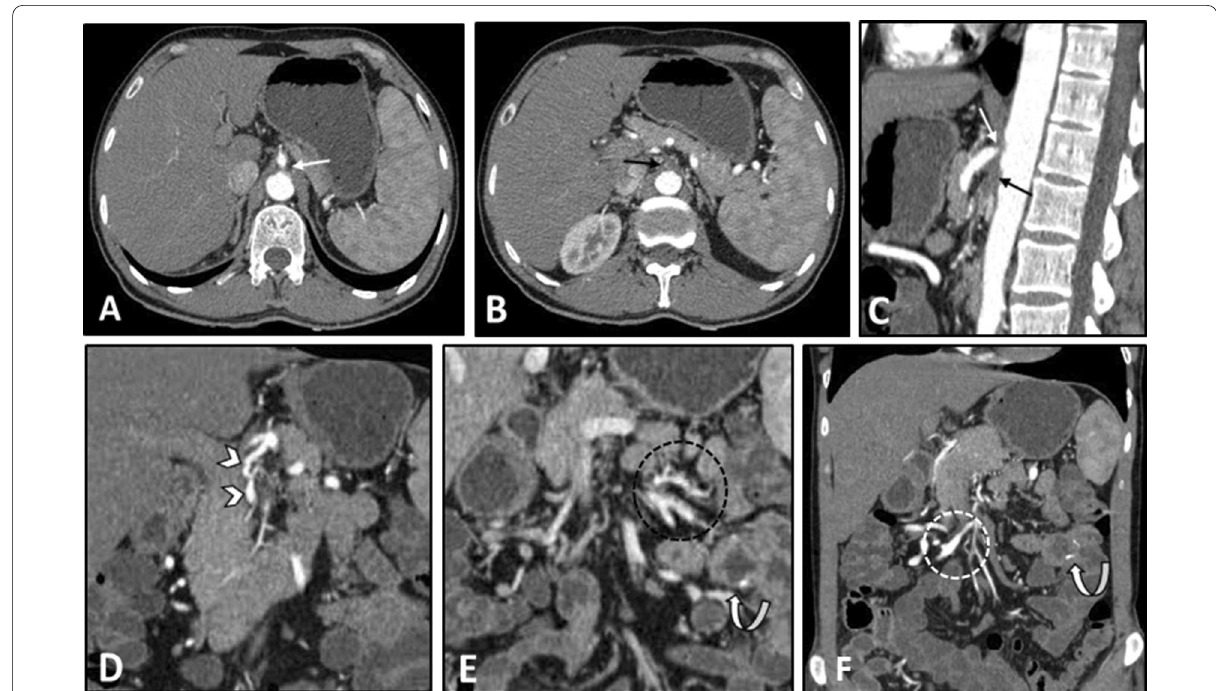
Fig. 5 Vasculitis of splanchnic arteries in a 43-year-old male with a history of pathologically proven polyarteritis nodosa and segmental jejunal resection due to ischemia. He complains of postprandial abdominal pain, nausea, vomiting, hypertension, and elevated inflammatory markers. CTE was done. Axial and sagittal images ( A – C ) in the arterial phase demonstrate severe stenosis at the origin of the celiac trunk (thin white arrows) and complete occlusion and irregularity of proximal SMA (thin black arrows). Coronal CT images ( D – F ) reveal vessel irregularity and mild degree of aneurysmal dilations in a collateral branch between celiac trunk and SMA (white arrowheads), thickening and irregularity in jejunal branches of SMA (black dotted oval) adjacent to the previous site of jejunal resection and anastomosis (white curved arrows). The ileocolic branch of SMA also shows focal aneurysmal dilatation and mild thickening (white dotted